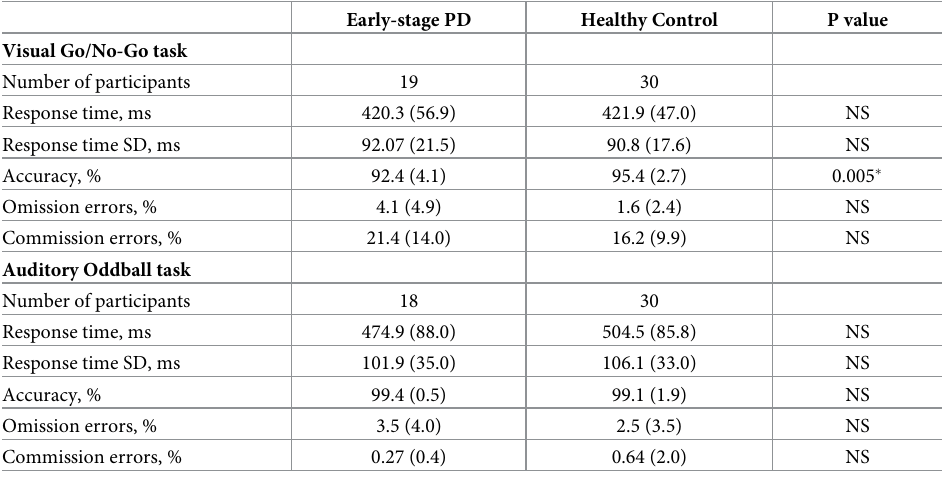
Table 2. Results of the cognitive tasks